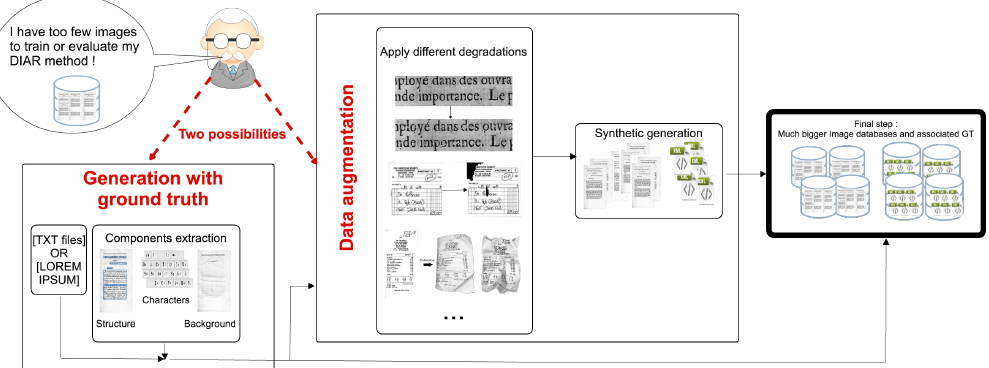
Figure 1. According to the needs of the DIAR researcher, it is possible to generate synthetic document images (and their ground truth) in different ways. First possibility: if a researcher has real document images but without any ground truth, DocCreator can generate synthetic images that look like the real ones, and of course, with the associated ground truth. Second possibility: a researcher has a ground-truthed database but it is too small or not heterogeneous enough. DocCreator provides several degradation algorithms to augment the dataset. By degrading text ink, paper shape or background colours it is possible to create a representative document image database where many defects are present. This complete database is finally useful for very precise performance evaluation or to provide multiple cases for retraining processes (in algorithms embedding a learning